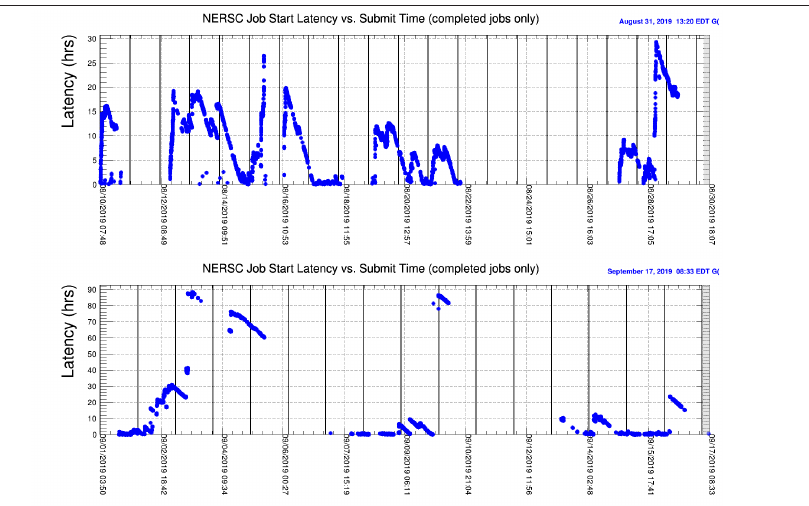
Figure 4. RunPeriod2018-08 job latency at NERSC for batches 01(top) 03(bottom). For the top plot, the “regular” queue was used while in the bottom plot the “low” priority queue was used. It is not clear whether the longer latencies in the bottom plot are due purely to the “low” priority queue or whether other demands on the system at the time played a role.